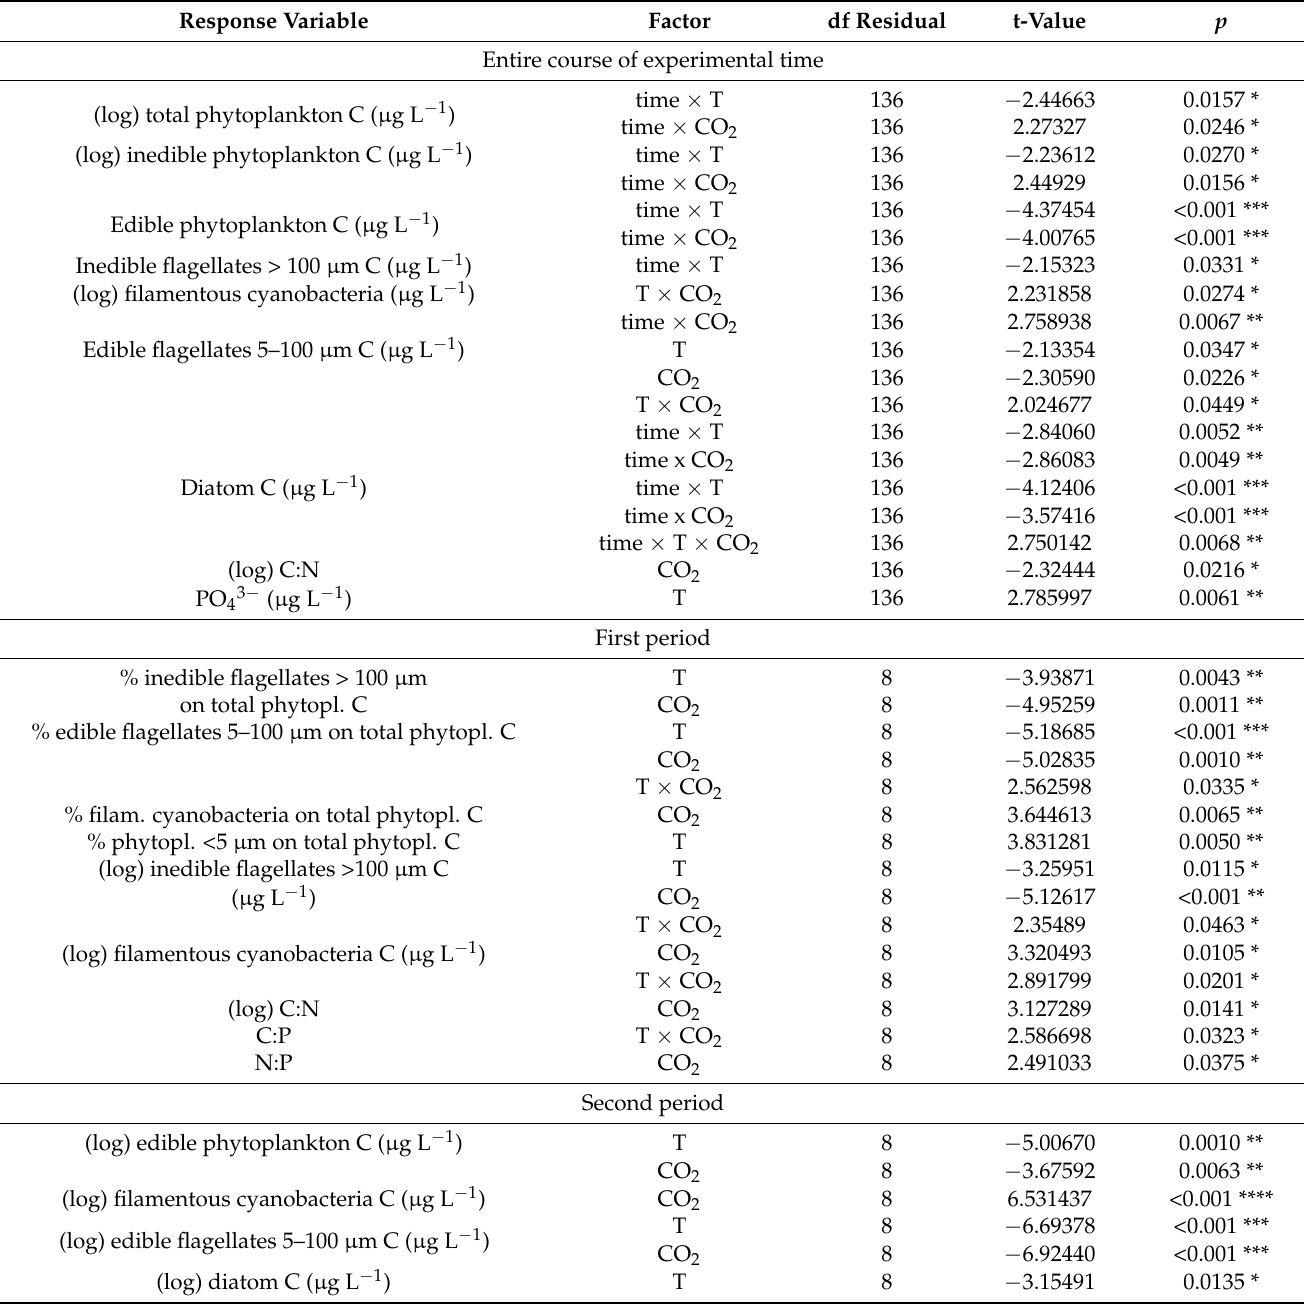
Table A1. Significant results of generalized least squares model (gls) testing for the effect of temperature (T), CO 2 , time, and the interaction effect of temperature and CO 2 (T × CO 2 ), time and temperature (time × T), time and CO 2 (time × CO 2 ) and/or the interaction of time, temperature and CO 2 (time × T × CO 2 ) over the entire course of experimental time, for the first period and for the second period. * p ≤ 0.05, ** p < 0.01, *** p < 0.001. Response